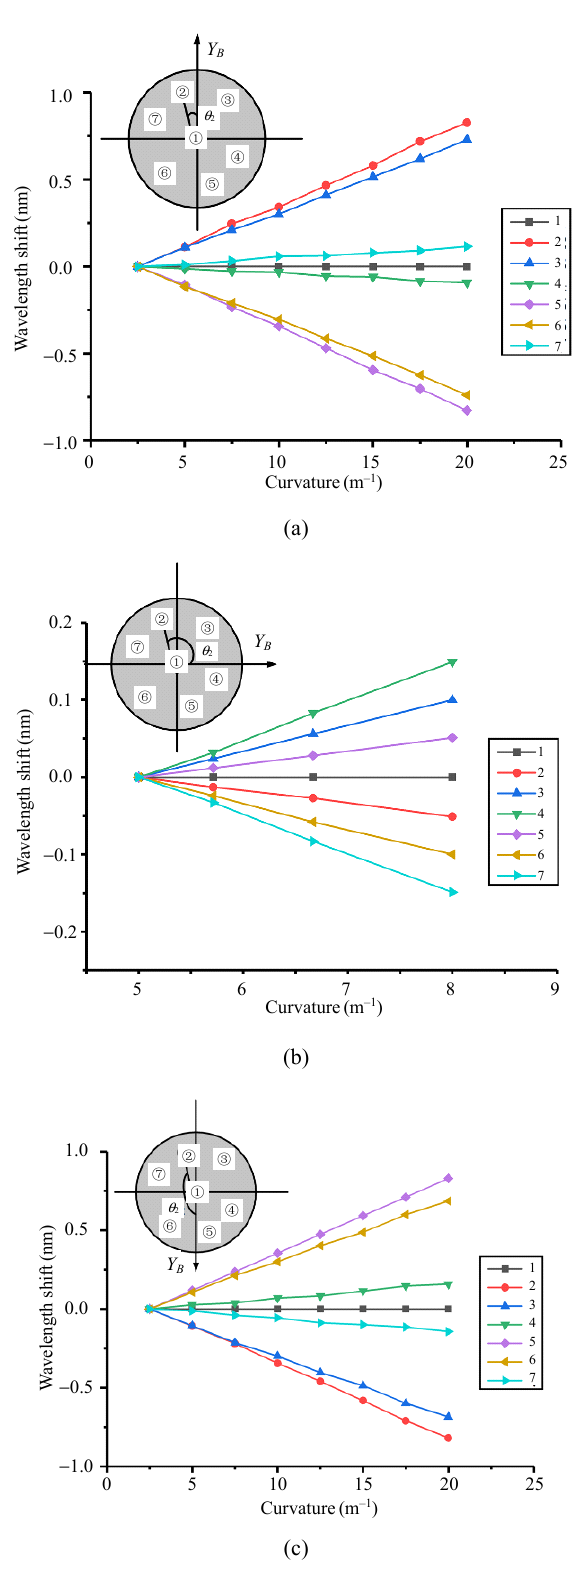
Fig. 11 Central wavelength shift of seven cores during the curvature sensing of (a) Part 1, (b) Part 2, and (c) Part 3 of the deformation device.